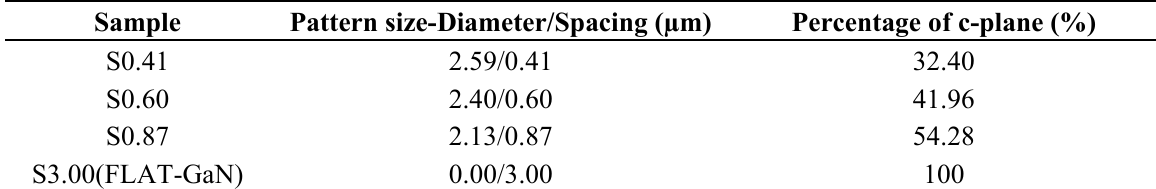
Figure 1. SEM images of ( a ) top-view; and ( b ) cross-section of S0.41 concave patterned sapphire substrate (CPSS). Table 1. Diameter and spacing of CPSS with various percentage of